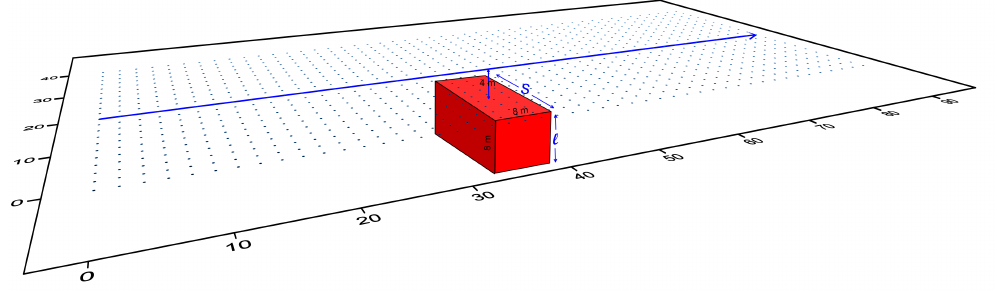
Figure 2. Simulation of a 3D ERT survey on a model of a prism-shaped resistive block (10 5 Ω · m) with the orthogonal width s not equal to the longitudinal and vertical sizes l in a background rock (100 Ω · m). The size l of the square section is equal to 8 m. The depth of the top of the prism is 4 m. The thick blue line indicates the considered 2D ERT survey carried out over the prism center in the orthogonal direction to the length s of the prism.